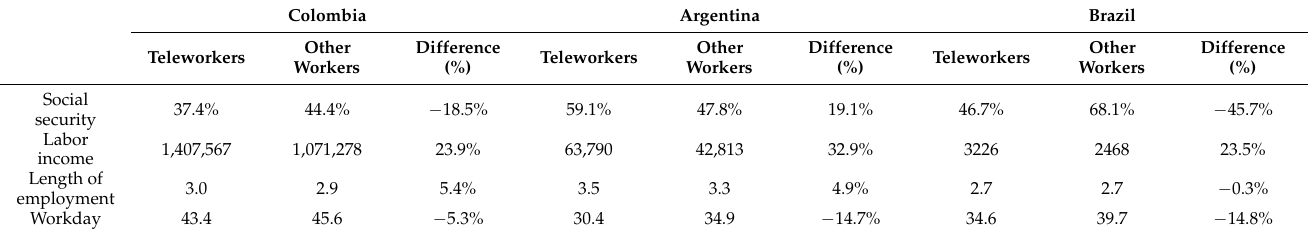
Table 2. Average values of job quality components for Argentina, Brazil, and Colombia, 2021.